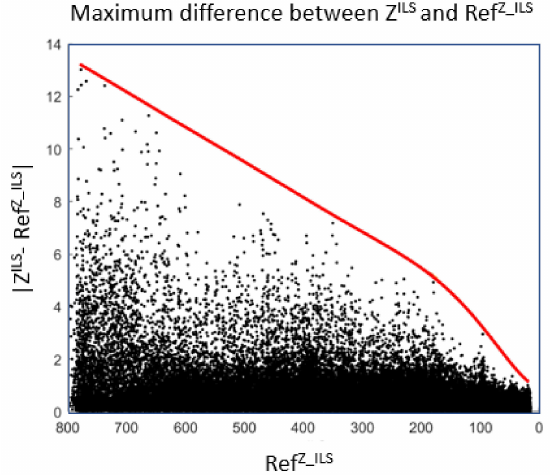
Figure 19. Envelope for ILS using real values.